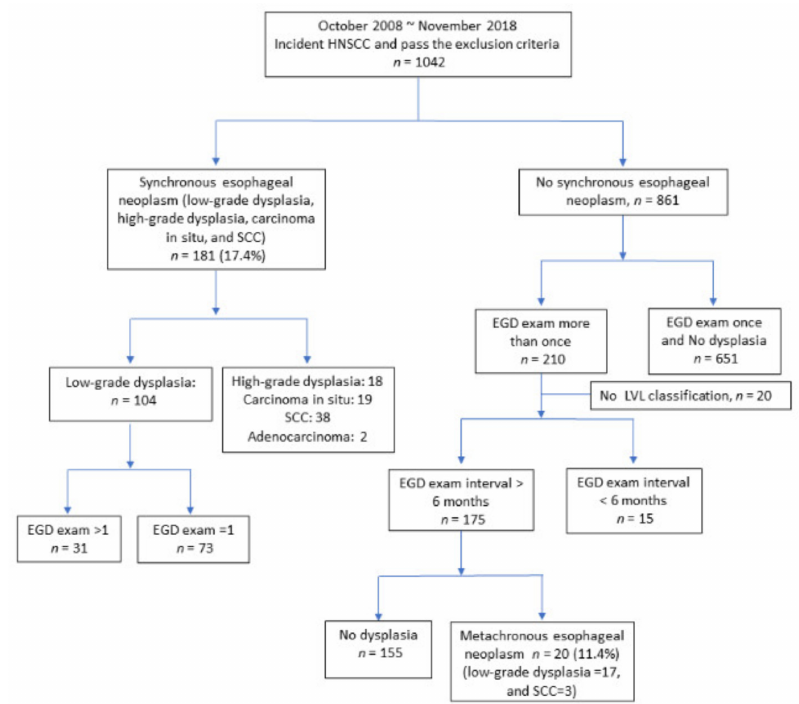
Figure 1. Case distribution of synchronous and metachronous ESCNs. Abbreviations: ESCN, esophageal squamous cell neoplasm; HNSCC, head and neck squamous cell carcinoma; SCC, squamous cell carcinoma; LVL, Lugol voiding lesion; EGD,